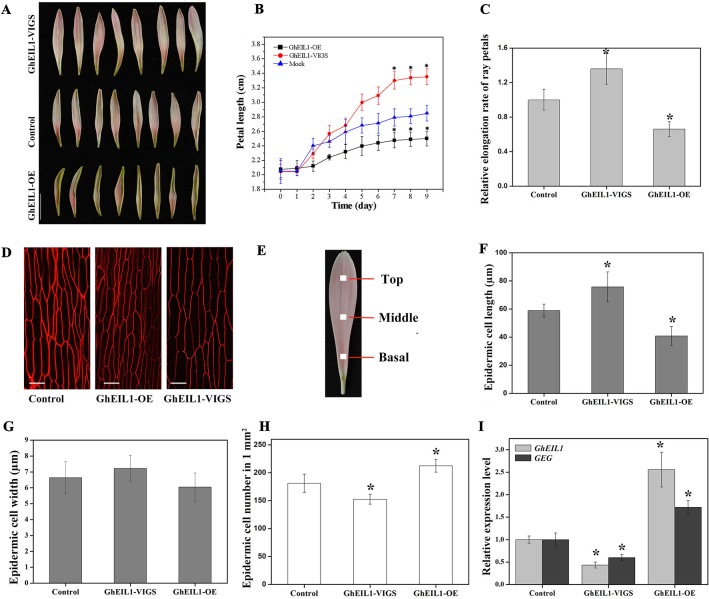
Petals with transiently overexpressed GhEIL1 or after virus-induced gene silencing (VIGS) in G. hybrida. (A) Phenotypes of GhEIL1-VIGS, GhEIL1-OE, and control petals. (B) Time-course dynamics of petal length in control, GhEIL1-VIGS, and GhEIL1-OE petals after transformation (n = 30). (C) Relative elongation rate of ray petals. (D) Morphological characterization of adaxial epidermal cells in the basal region of control, GhEIL1-OE, and GhEIL1-VIGS petals. (E) Blocks (1 mm2) at the center of the basal, middle, and top regions of ray petals were sampled for morphological characterization of petal cells. Cell length (F), cell width (G), and cell number (H) of control, GhEIL1-VIGS, and GhEIL1-OE petals in the basal region. (I) Expression level of GhEIL1 and GEG in control, GhEIL1-VIGS, and GhEIL1-OE petals. Experimental petals were collected after 9 days cultivation. Scale bars represent 1 cm (A) or 20 µm (D). All values indicate means ± SD from at least three biological replicates. Significant differences were determined using ANOVA and Tukey’s HSD: *p < 0.05.